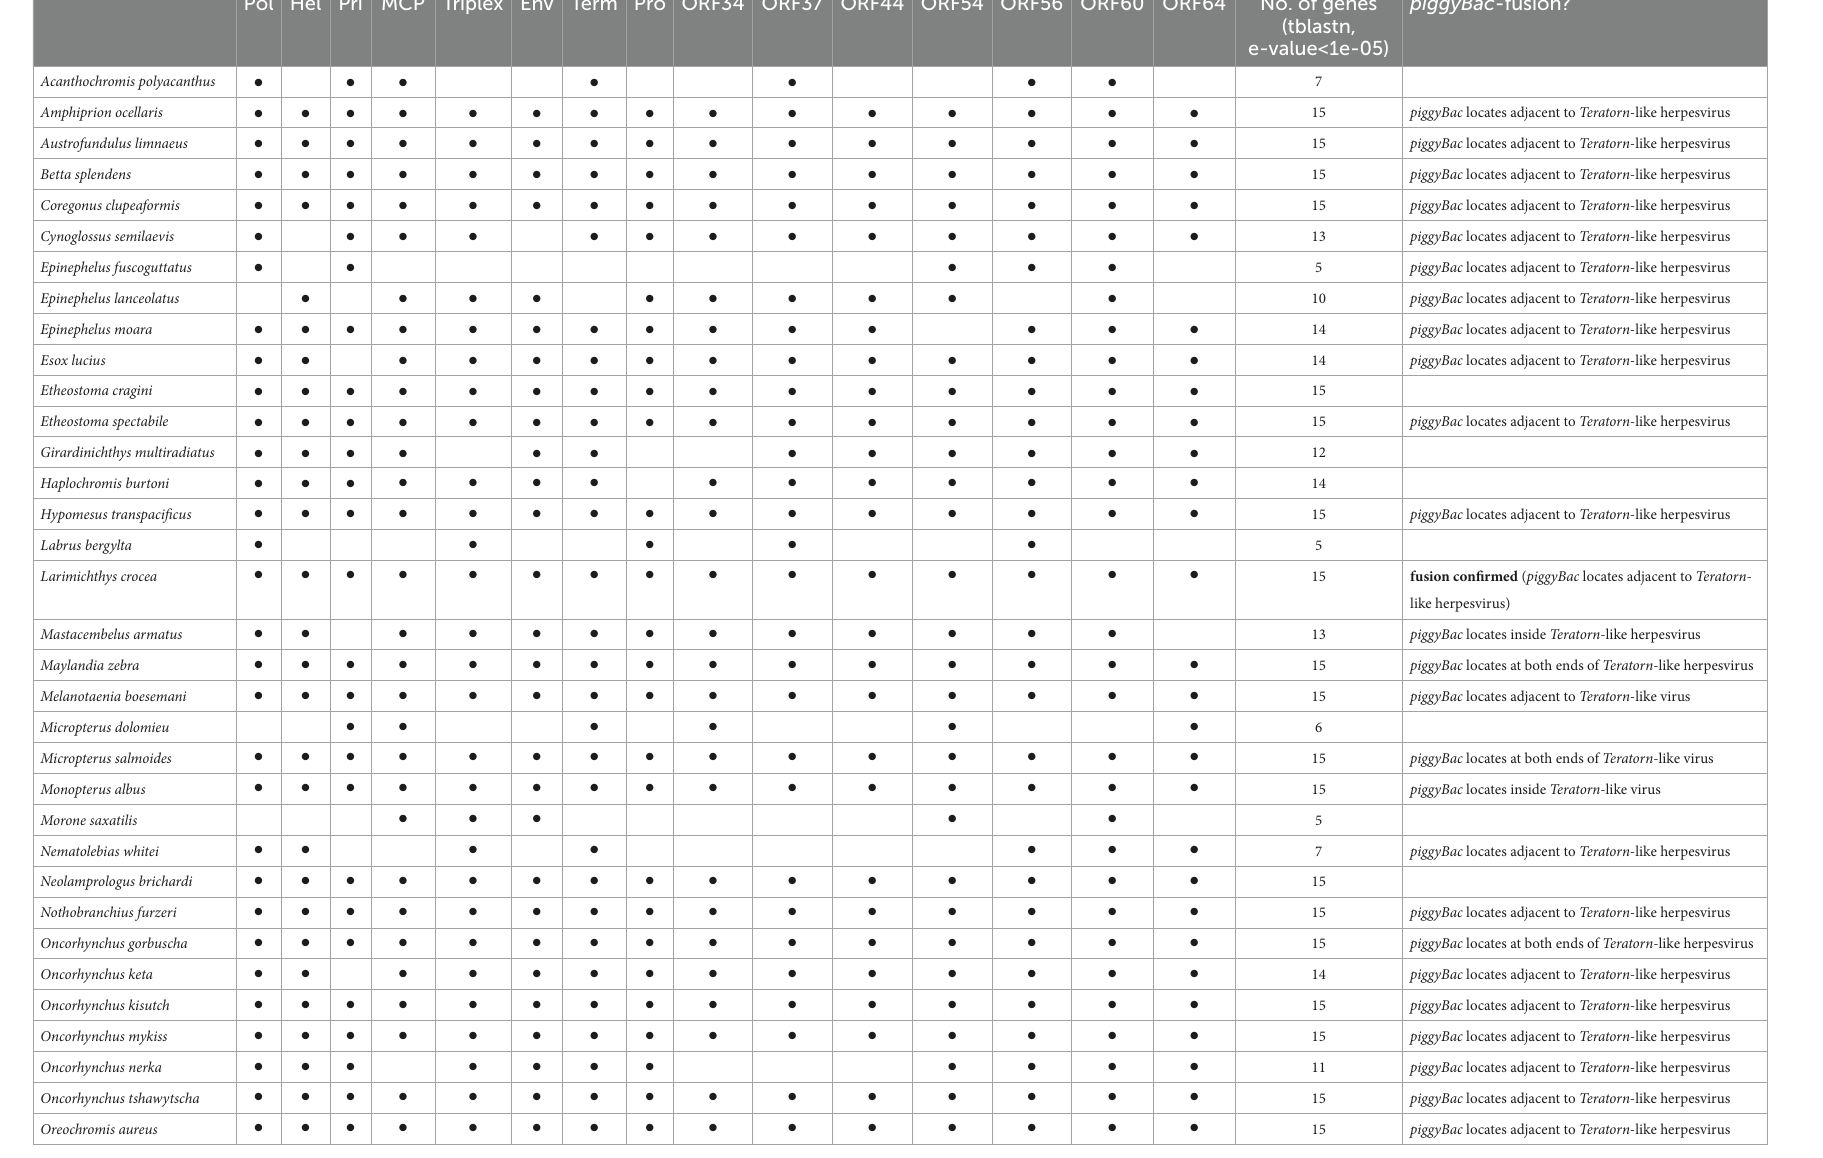
TABLE 1 Tblastn of alloherpesvirus core genes of medaka Teratorn against teleost genomes. Pol Hel Pri MCP Triplex Env Term Pro ORF34 ORF37 ORF44 ORF54 ORF56 ORF60 ORF64 No. of genes